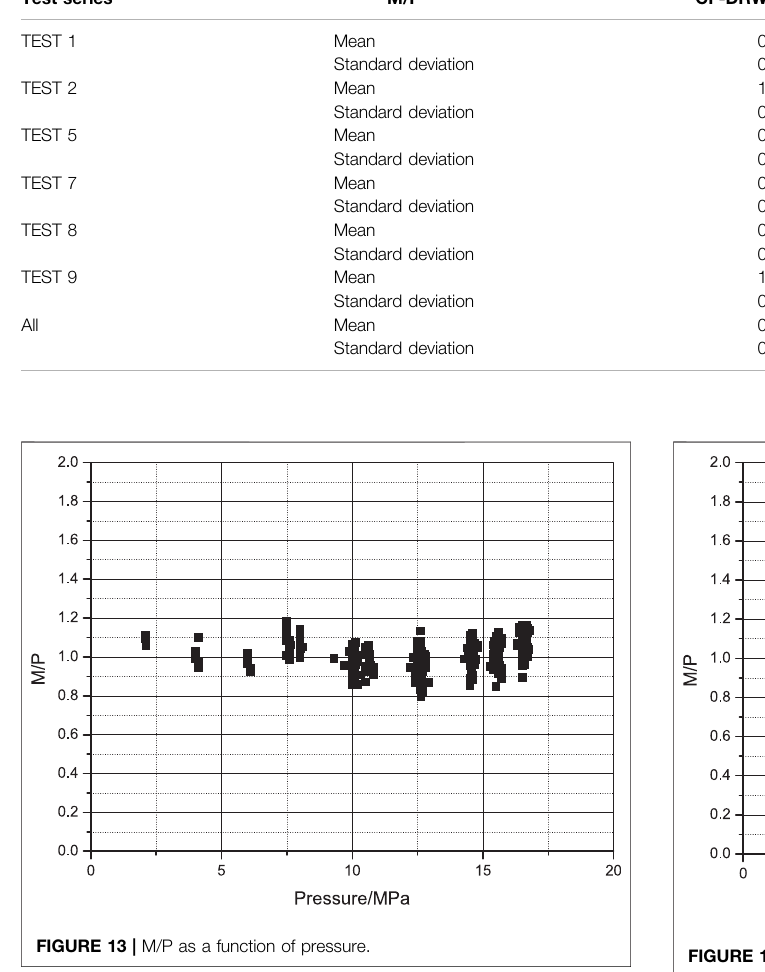
TABLE 3 | Statistical results of the CHF mechanistic model and CF-DRW correlation. Test series M/P CF-DRW correlation